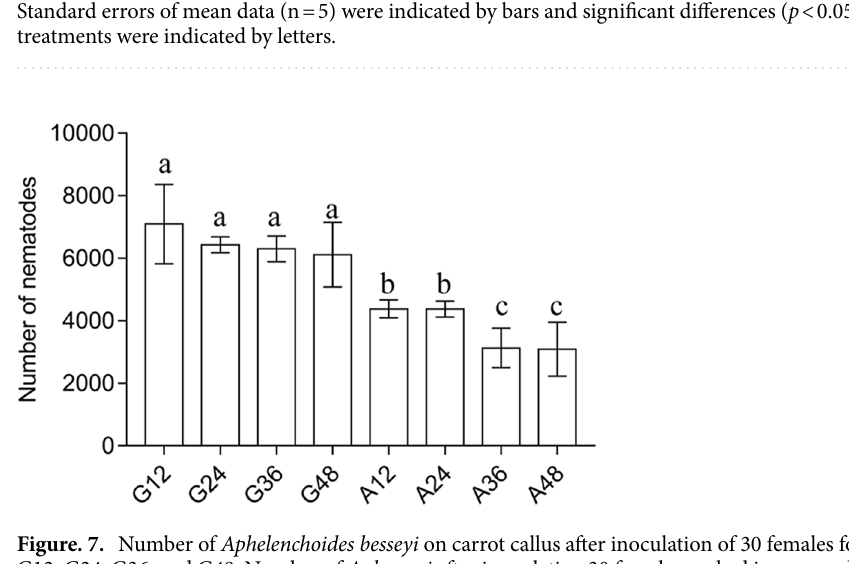
Figure. 7. Number of Aphelenchoides besseyi on carrot callus after inoculation of 30 females for 35 days. G12, G24, G36, and G48: Number of A. besseyi after inoculating 30 females soaked in non-endogenous gfp dsRNA solution for 12 h, 24 h, 36 h, and 48 h, respectively; A12, A24, A36, and A48: Number of A. besseyi after inoculating 30 females soaked in Ab-atps dsRNA for 12 h, 24 h, 36 h, and 48 h, respectively. Standard errors of mean data (n = 5) were indicated by bars and significant differences ( p < 0.05) between treatments were indicated by